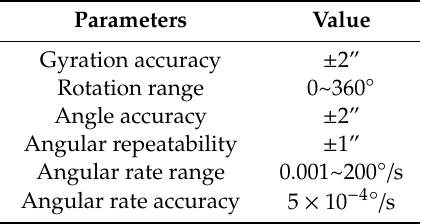
Table 4. Main indexes of SGT-3T